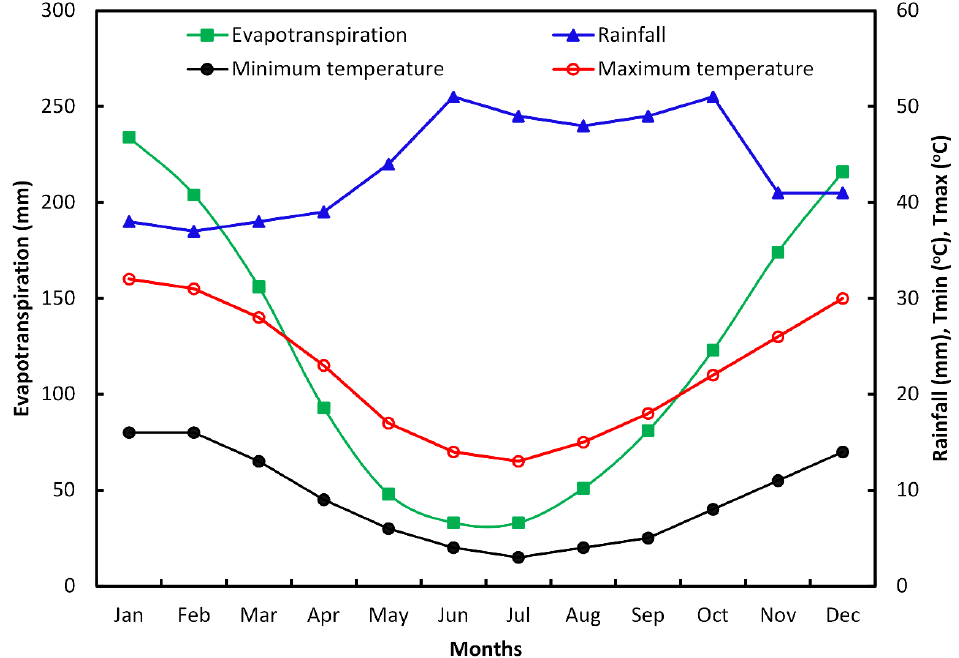
Figure. 1 : Average historical weather data (rainfall, temperature, and evapotranspiration) for Wagga Wagga, NSW, Australia (1989 –